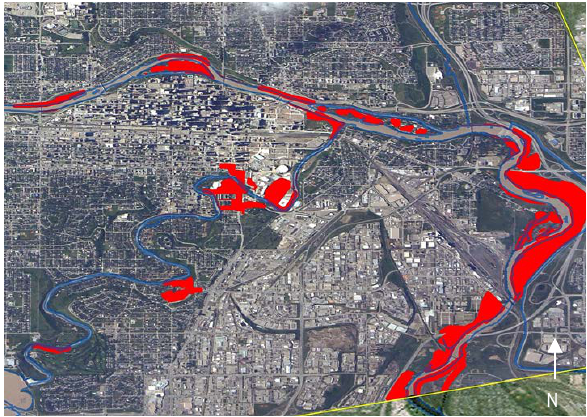
Figure 5. ISERV scene used to map flooding in Calgary, Alberta, Canada on 22 June 2013. Red areas are